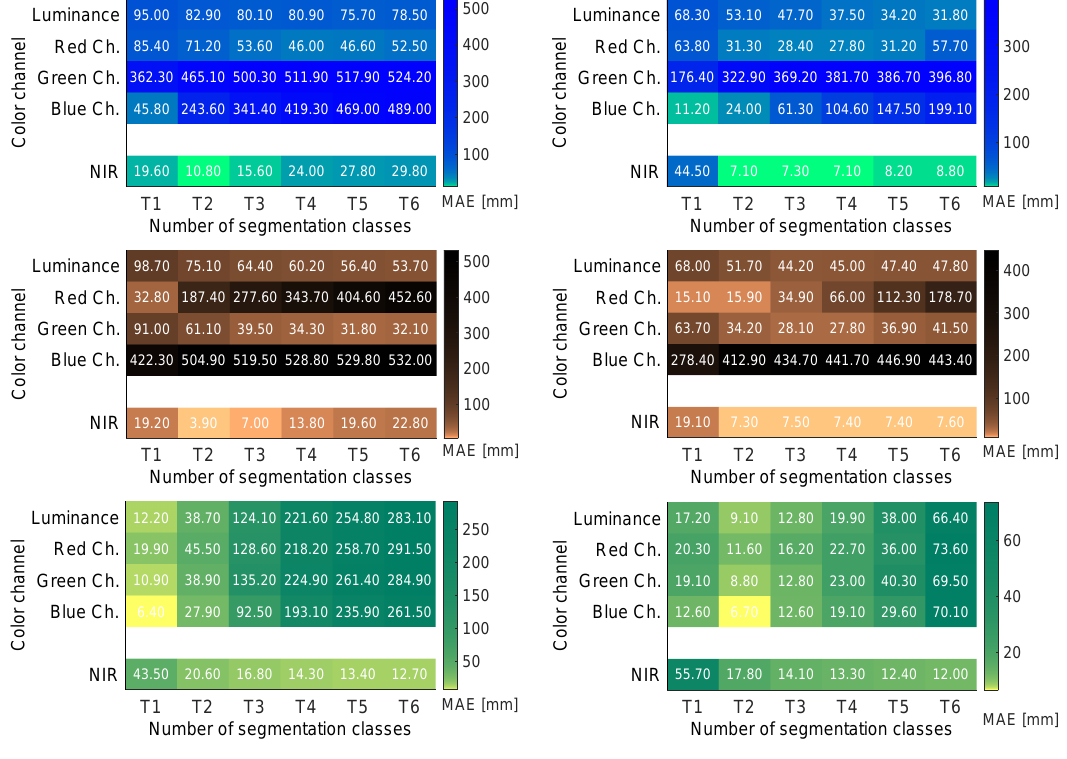
Figure 7. Mean absolute error (MAE) in mm between unfiltered and a priori known bar lengths for all experimental tests (E6, left , and E7, right ) treated with the large image crop. From top to bottom , heatmaps show MAE values estimated from images of the blue ( top ), red ( middle ), and white ( bottom ) bars. In each heatmap, rows indicate MAEs obtained for different color channels: the top four rows report values for RGB images processed through four gray-scale conversion modalities (luminance, red, green, and blue channels). The bottom row refers to values for the NIR images. Values are reported for all the segmentation classes (T1 to T6). Table 8. Optimal combinations of gray-scale conversion modality (red, green, and blue channel, ch.) and number of segmentation classes (T RGB and T NIR for RGB and NIR, respectively) for each bar (blue, red, and white) and experimental test (E6 and E7). Images are treated with the large